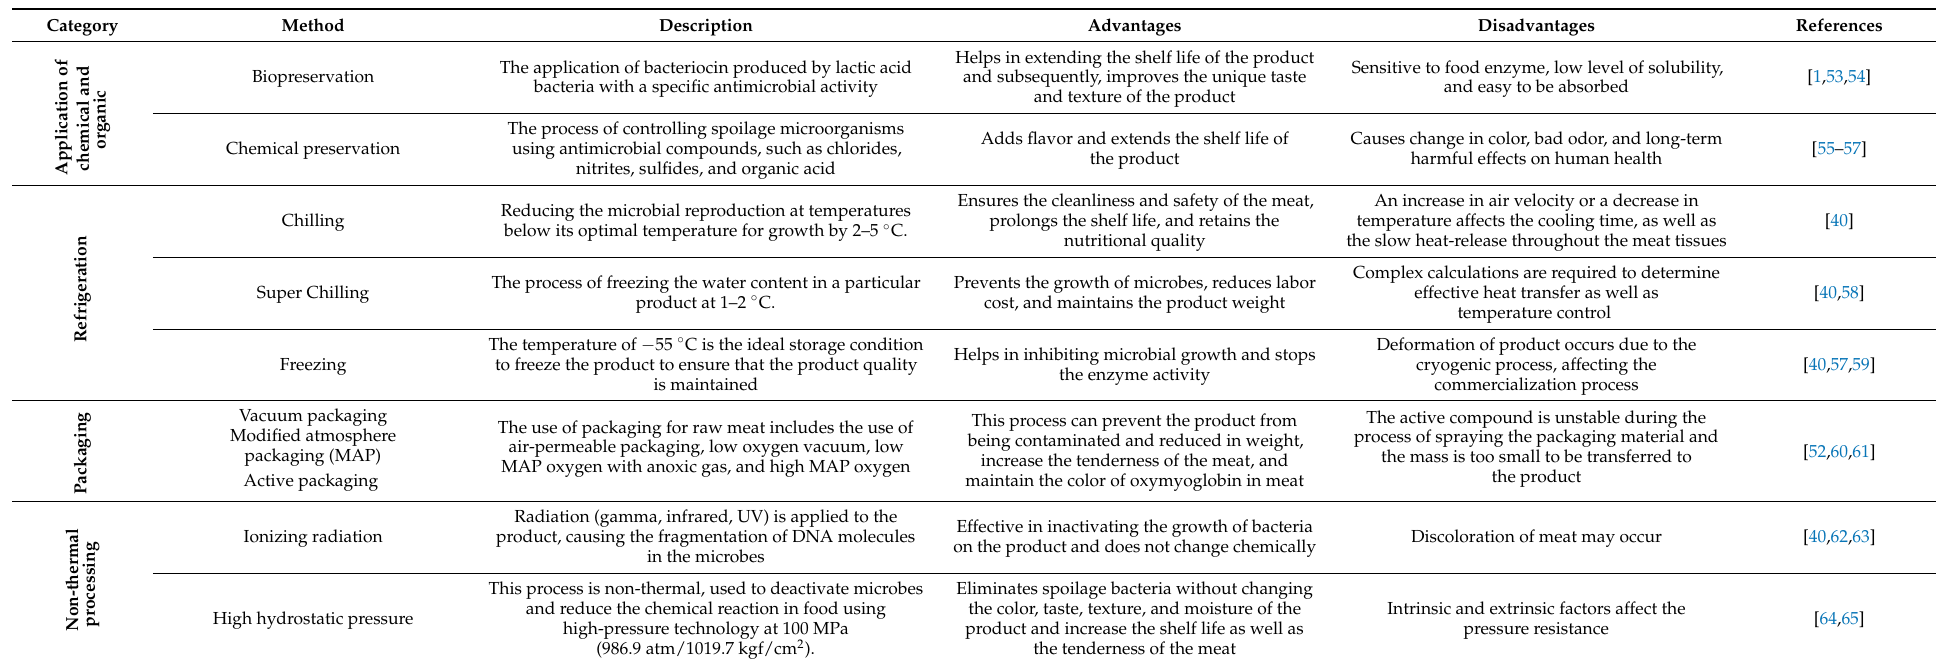
Table 5. Various methods used in preserving